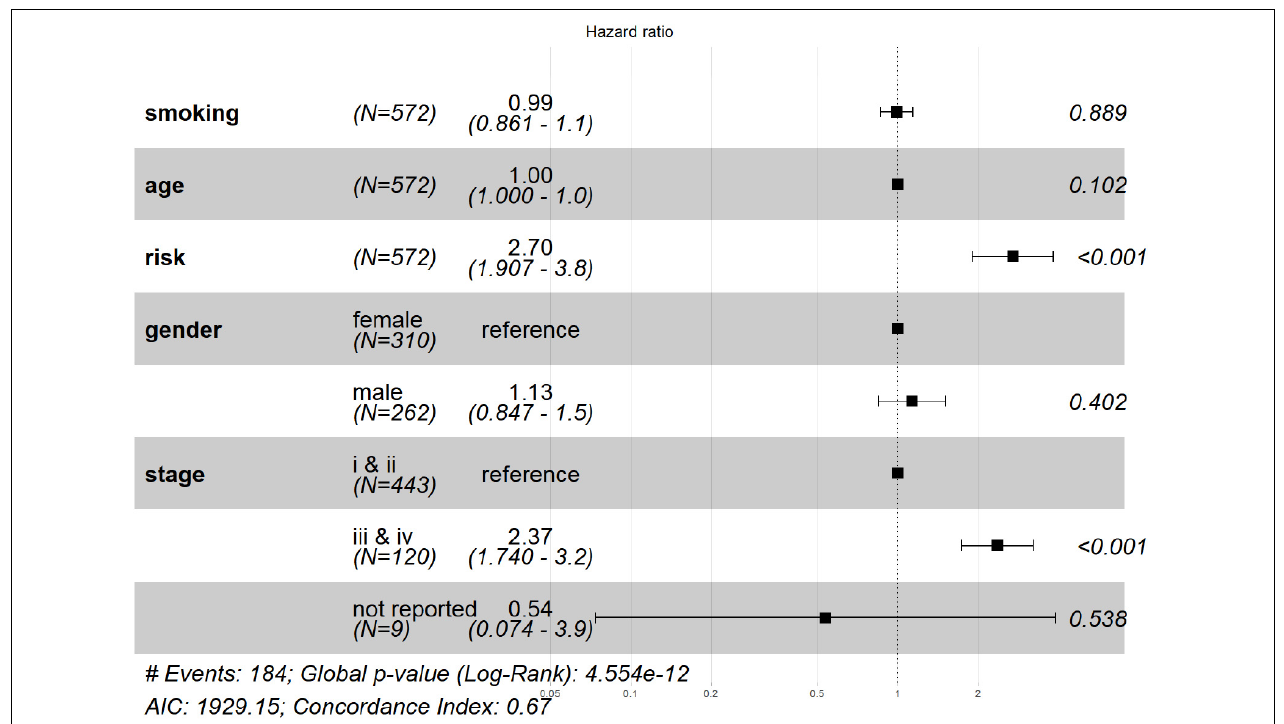
FIGURE 5 | Verification that the signature is an independent prognostic factor. From left to right, the column represented: factor name, number of subjects, HR (lower and upper 95% value), the HR plot, and the p -value. The result of multivariate Cox regression showed that risk score and tumor stage are significant prognostic factors for LUAD patients.